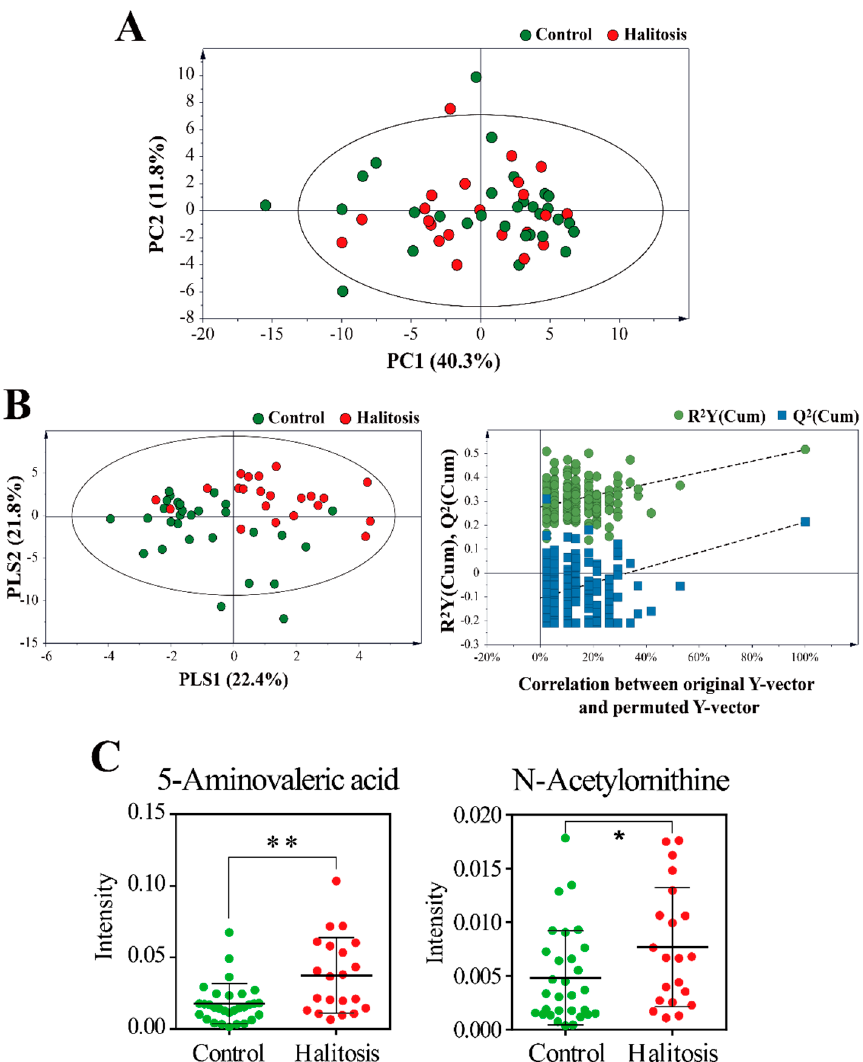
Figure 3. ( A ) The principal component analysis (PCA) built upon the gas chromatography–mass spectrometry (GC-MS) data of saliva samples from the control and the halitosis groups. ( B ) The supervised partial least-squares discriminant analysis (PLS-DA) show the discrimination between groups. The R 2 X, R 2 Y, and Q 2 of PLS-DA are 0.442, 0.516, and 0.213, respectively. Permutation tests with 200 iterations were performed to validate the model. These tests compared the goodness of fit of the original model with the goodness of fit of randomly permuted models. ( C ) Scatter dot plots of two metabolites that contributed to the discrimination in the PLS-DA model (VIP > 1.0 and p < 0.05) between the control and halitosis groups. The y-axis represents the normalized intensity of each metabolite. * p < 0.05; ** p < 0.01.